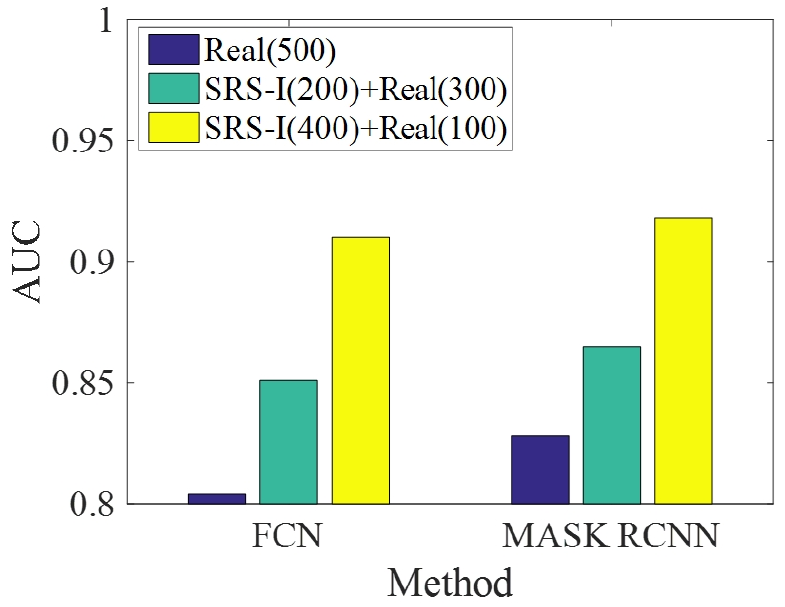
Figure 14. AUC of the selected methods (algorithm index corresponds to the No. shown in Table 1). “SRS-I(400) + Real(100)” (TPR: 94.5% and FPR: 7.6%) outperformed the compared